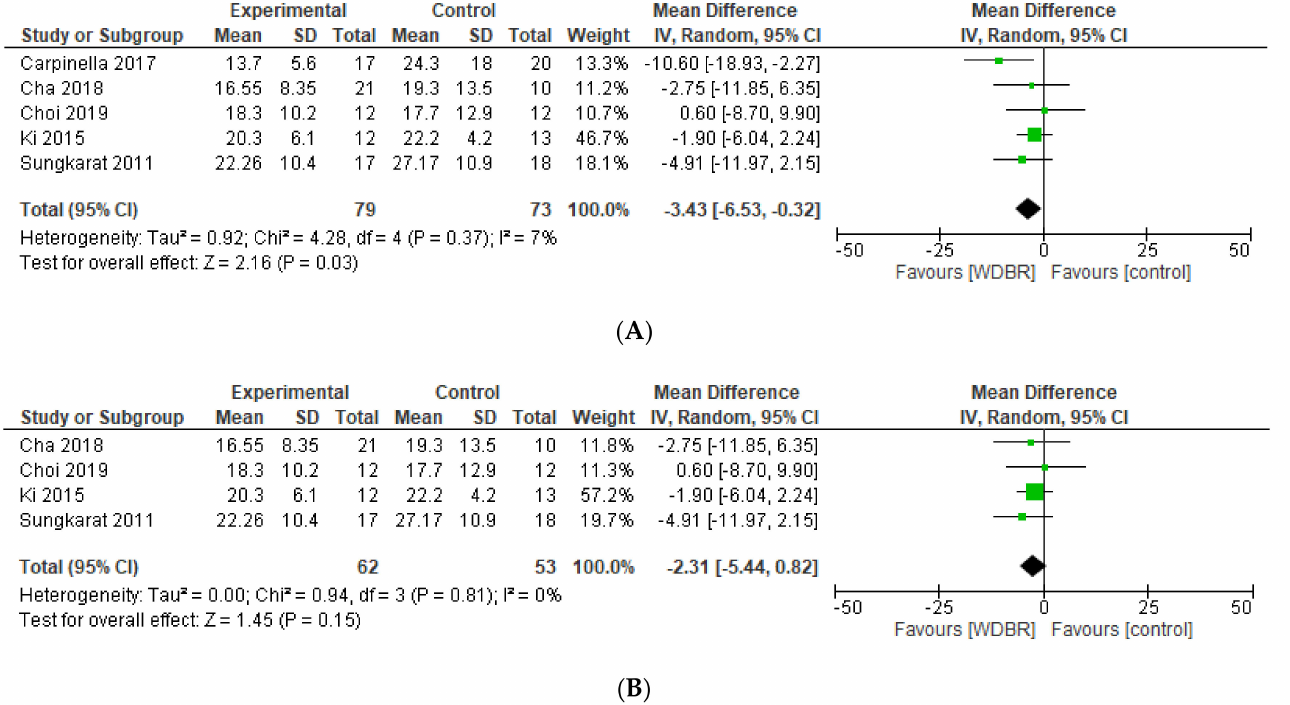
Figure 5. Forest plots of studies comparing add-on WDBR versus control. ( A ) Overall effect of WDBR versus control at postassessment on TUG. ( B ) Subgroup analysis: effect of WDBR (pressure sensors with auditory biofeedback) versus control at postassessment on